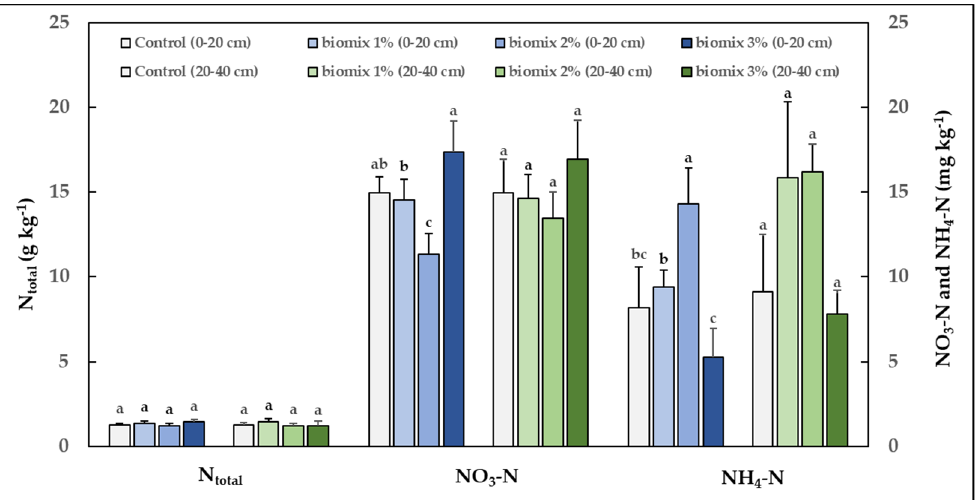
Figure 6. Average N total (g kg − 1 ), NO 3 -N (mg kg − 1 ) and NH 4 -N (mg kg − 1 ) concentrations and their standard deviations (SD) of samples of the four treatments at 0–20 cm and 20–40 cm depth. Each value is the mean of three replicates. Different letters above each column within the same parameter evaluated, indicate significant differences among treatments.